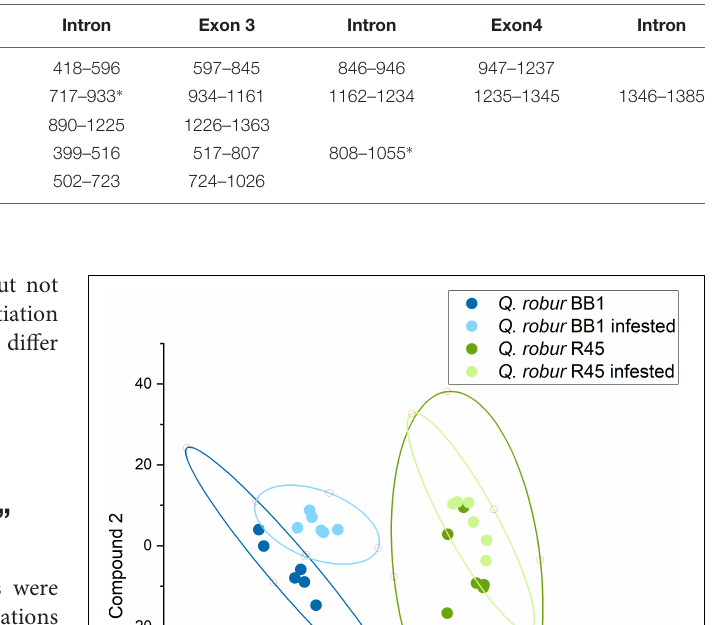
TABLE 2 | Structural features of the identified oak terpene synthase genes in the populations “BB1” and “R45.”